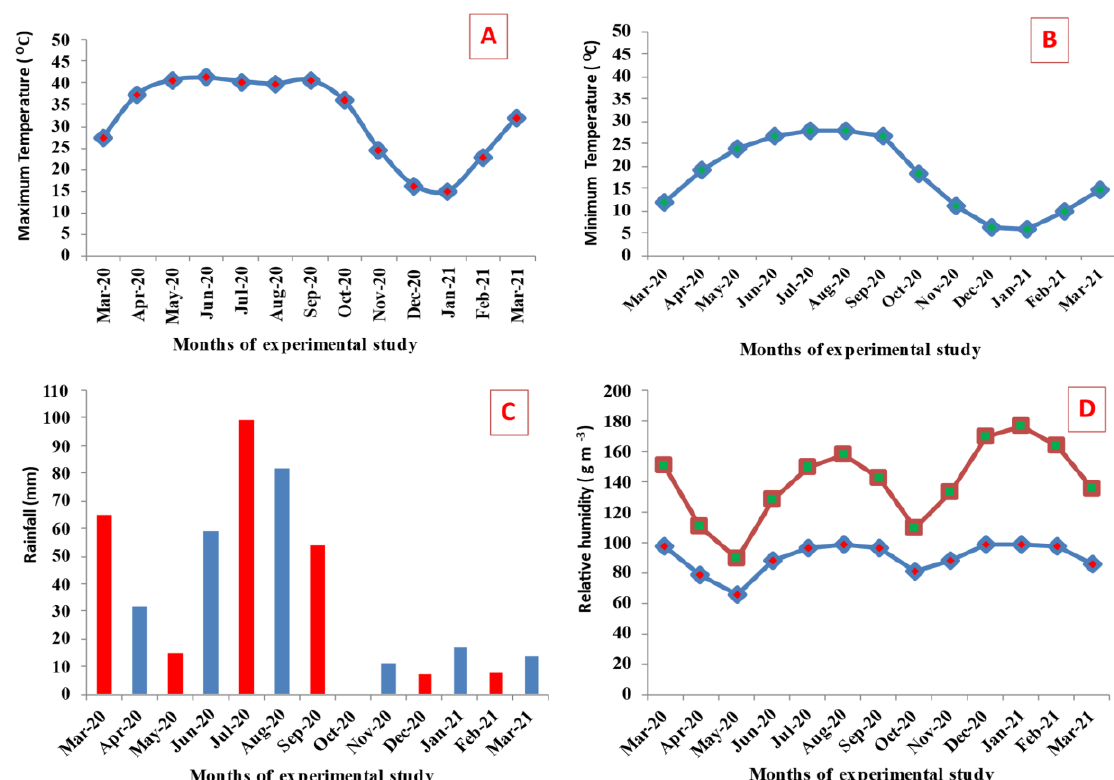
Figure 1. Maximum and minimum air temperatures ( A , B ), rainfall ( C ) and maximum and minimum relative humidity ( D ) during the experimental period from March 2020 to March 2021.